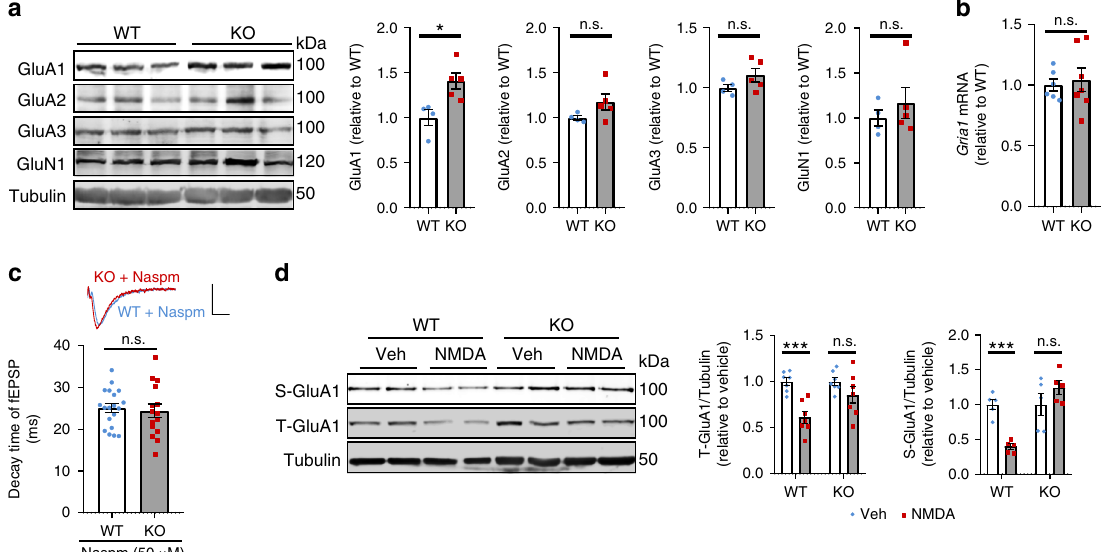
Fig. 4 Caspase-2 is required for GluA1 internalization and degradation. a Immunoblotting analysis and quanti fi cation of glutamate receptors in WT and Casp2 KO hippocampi. WT, n = 4; KO, n = 5. b Levels of Gria1 mRNA in WT and Casp2 KO hippocampi as revealed by quantitative RT-PCR with 18 s rRNA as internal control. WT, n = 6; KO, n = 7. c Decay time of fEPSP at CA1 pyramidal neurons in the presence of Naspm. WT, 19 slices from 3 mice; KO, 15 slices from 3 mice. Scale bars, 0.5 mV (vertical) and 10 ms (horizontal). d Immunoblotting analysis and quanti fi cation of surface and total GluA1 in cultured mouse hippocampal neurons treated with vehicle or NMDA. n = 5 – 7. Data are expressed as mean ± SEM. Two-tailed Student ’ s t test: n.s. no signi fi cance, * p < 0.05 and *** p < 0.001. Source data are provided as a Source Data fi